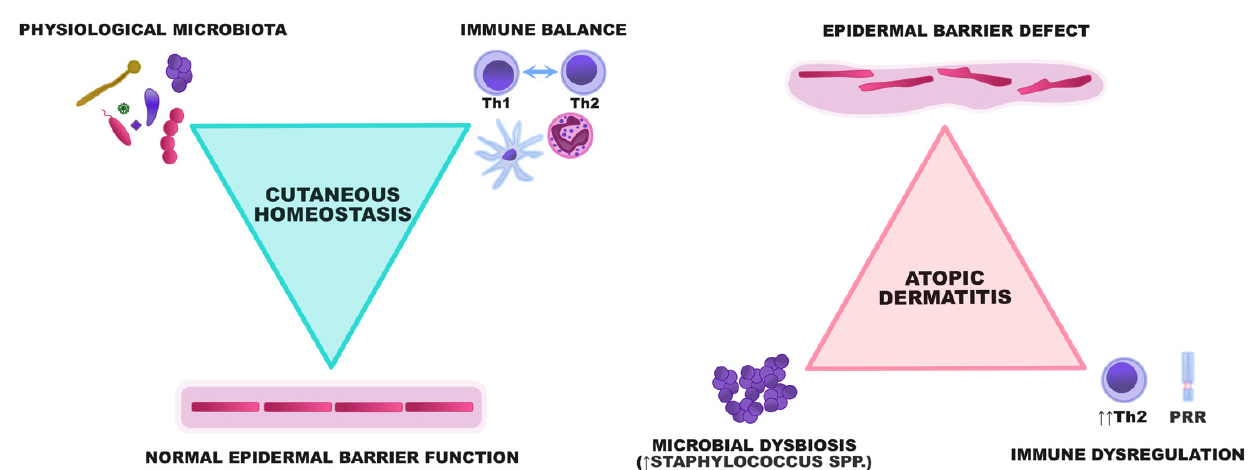
Figure 1. A graphical representation of the interactions between the epidermal barrier, microbiota, and the immune system. In healthy individuals, the epidermis constitutes a barrier preventing the uncontrolled proliferation of potentially harmful microorganisms. A diverse array of microbes participates in the crosstalk with the immune system and ensures its maturation to maintain immune balance within the skin. In AD, the epidermal barrier defect and dysregulation of innate and acquired immunity result in the enhanced adhesion and proliferation of some bacterial species, especially staphylococci. Microbial dysbiosis subsequently aggravates the skin defect by degrading the components of the epidermal barrier and potentiating Th2-skewing.